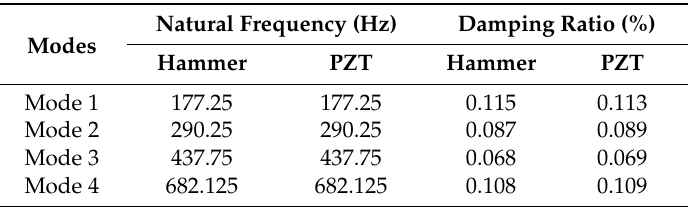
Table 4. Comparison of the modal parameters (natural frequency and damping ratio) between PZT excitation and Hammer excitation for the structure submerged in “infinite